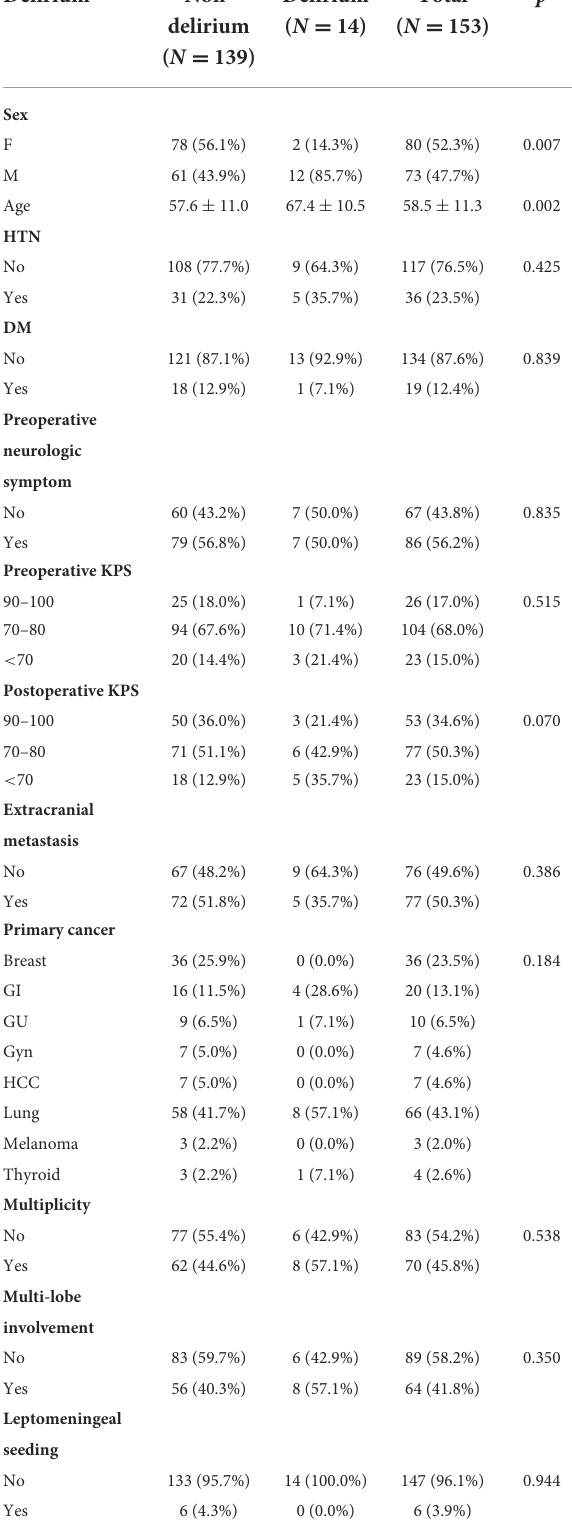
TABLE 1 Demographics of all cohorts ( N =